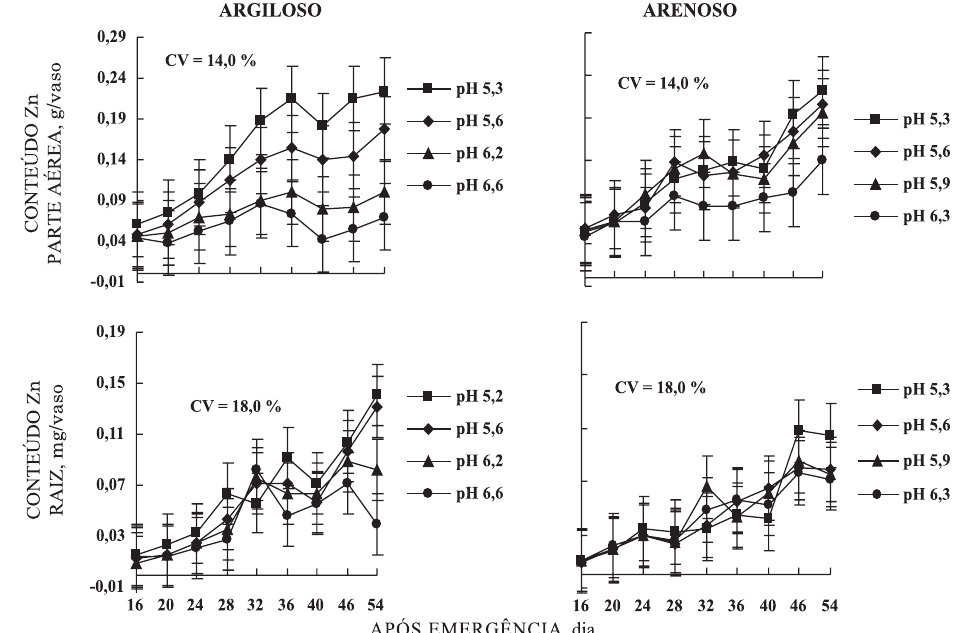
Figura 8. Conteúdo de zinco da matéria seca da parte aérea e do sistema radicular de plantas de soja, em diferentes épocas de avaliação após a emergência, em relação ao pH inicial do solo argiloso e do